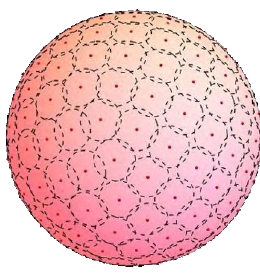
Figure 25 . The approximate disk tiling of a sphere for k = 192